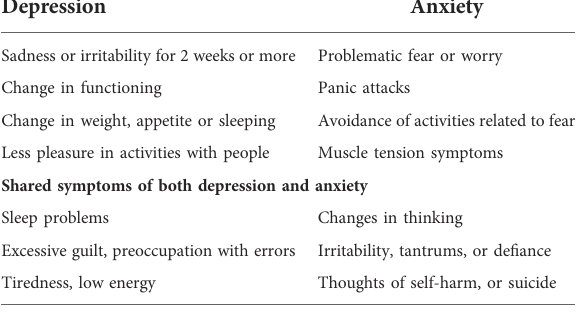
TABLE 2 Suspicious signs or symptoms of anxiety or depression in children and